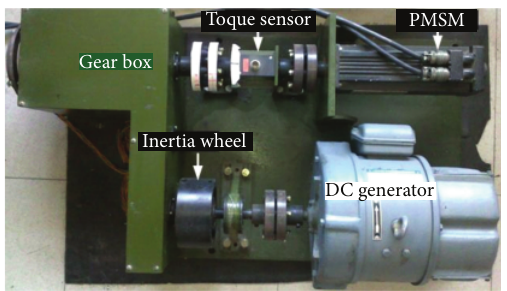
Figure 11: Experiment platform.